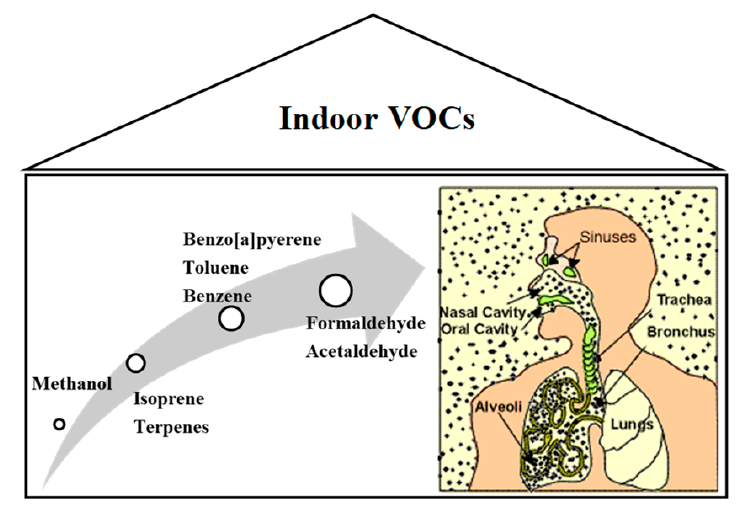
Figure 1. Impact of indoor Volatile Organic Compounds (VOCs) on human health.